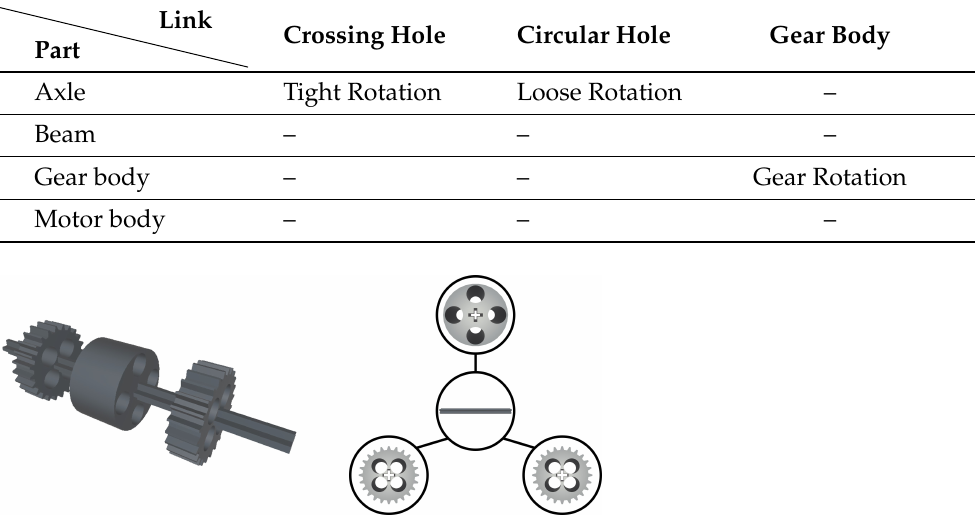
Figure 2. ( Left ) An example mechanical assembly. ( Right ) The graph representation for the